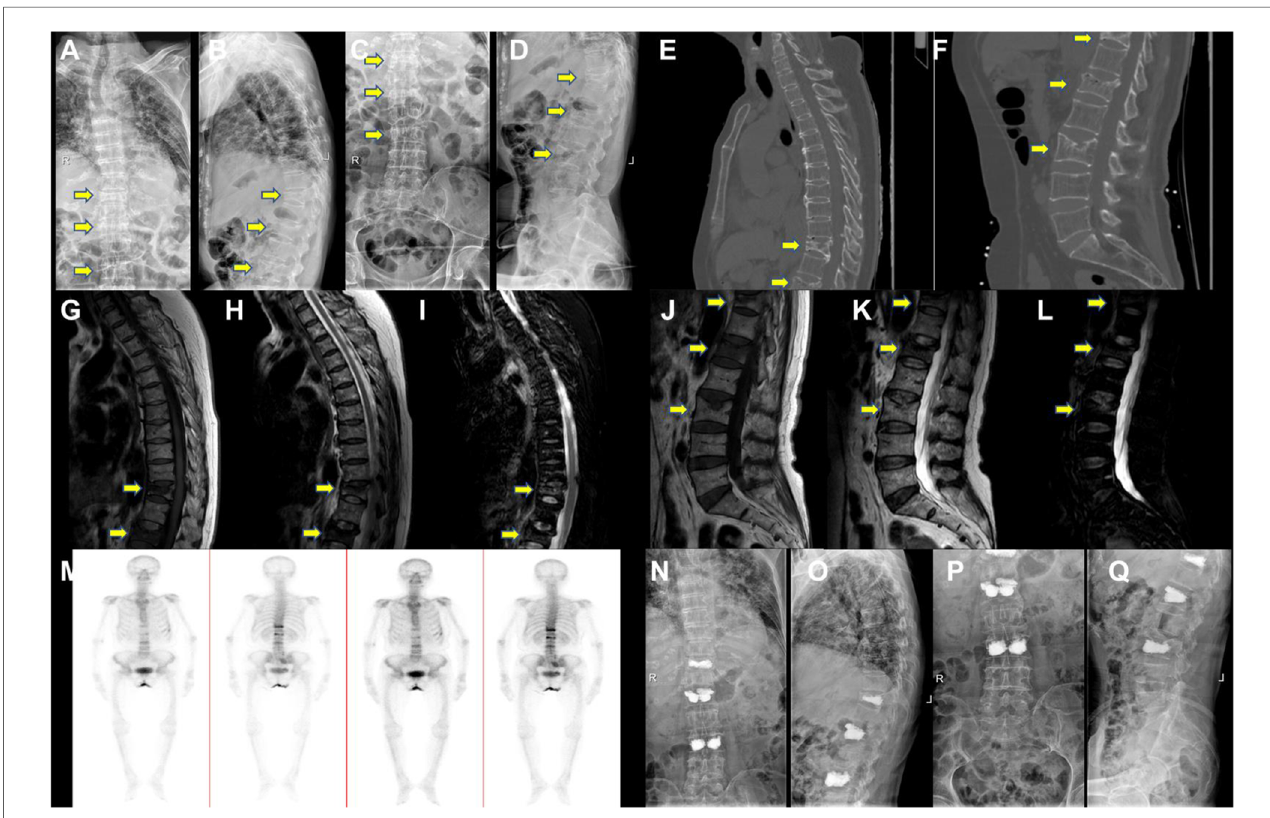
FIGURE 2 The representative patient ’ s medical images. Pre-Op digital radiography (DR) images of ( A,B ) thoracic and ( C,D ) lumbar. Representative CT images of ( E ) thoracic and ( F ) lumbar. Representative MRI images of ( G ) T1, ( H ) T2, and ( I ) STIR. Thoracic and ( J ) T1, ( K ) T2, ( L ) STIR lumbar ( M ) and ECT image. Post-Op DR images of ( N,O ) thoracic and ( P,Q ) lumbar. Yellow arrows point to the injured vertebral bodies. ECT, emission computed tomography.